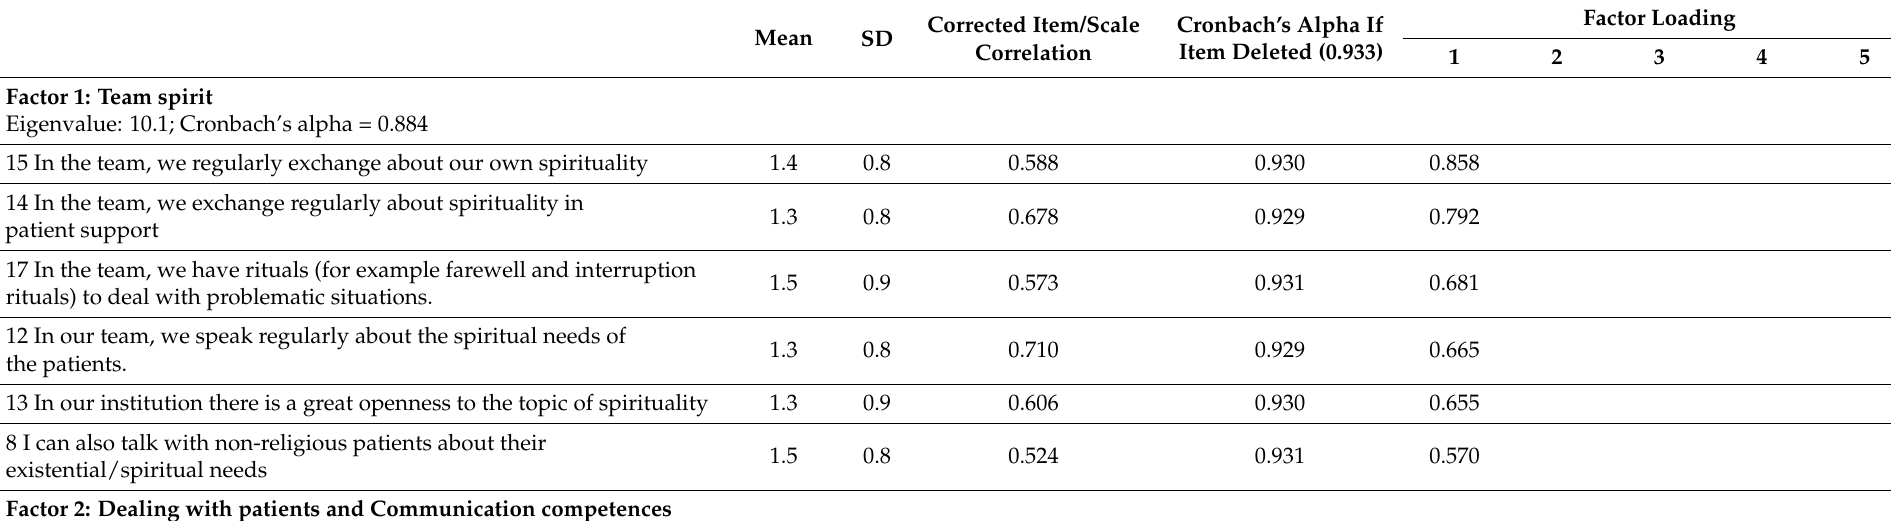
Table 2. Factorial structure of the 25-item SCCQ